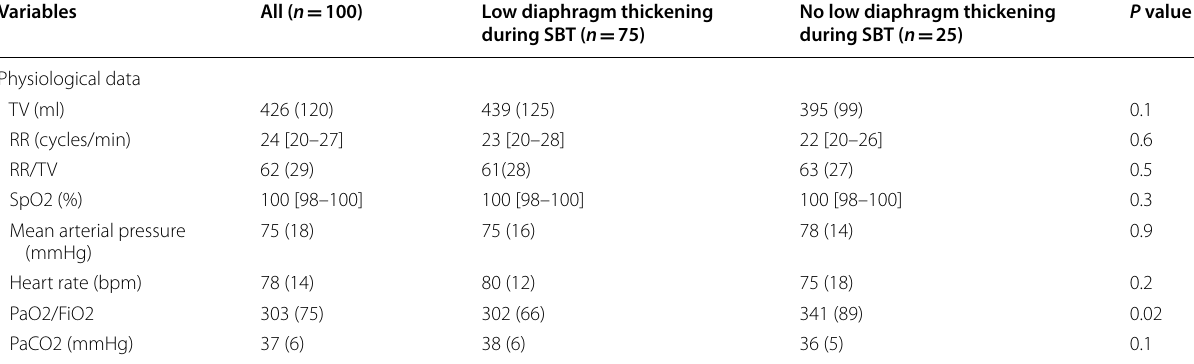
Table 2 Physiological measurements, according to diaphragm thickening during spontaneous breathing trial (SBT) with the settings used during the ultrasound assessment (pressure support and positive end-expiratory pressure set at 0 cmH O) 2